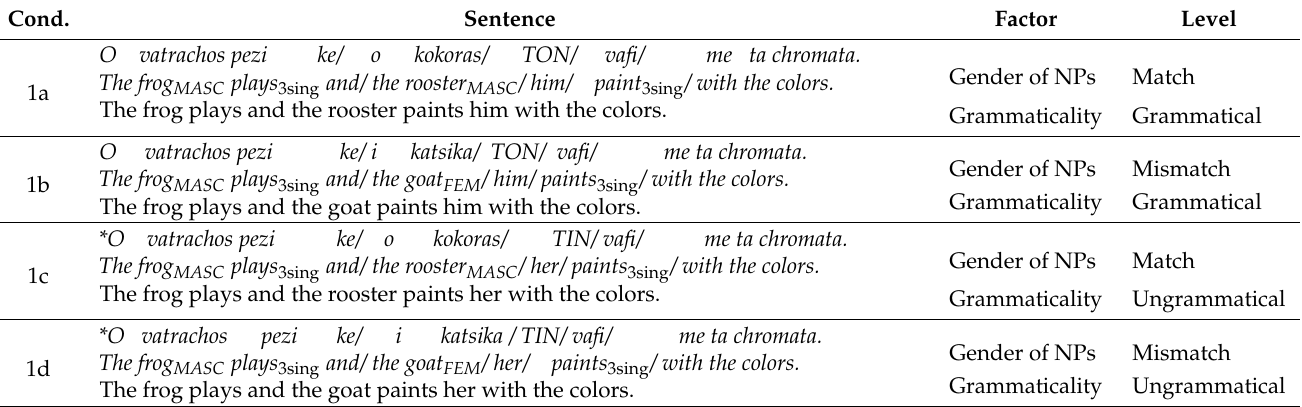
Table 7. Example of the conditions in the comprehension task. MASC: masculine, FEM: feminine. Cond. Factor Level